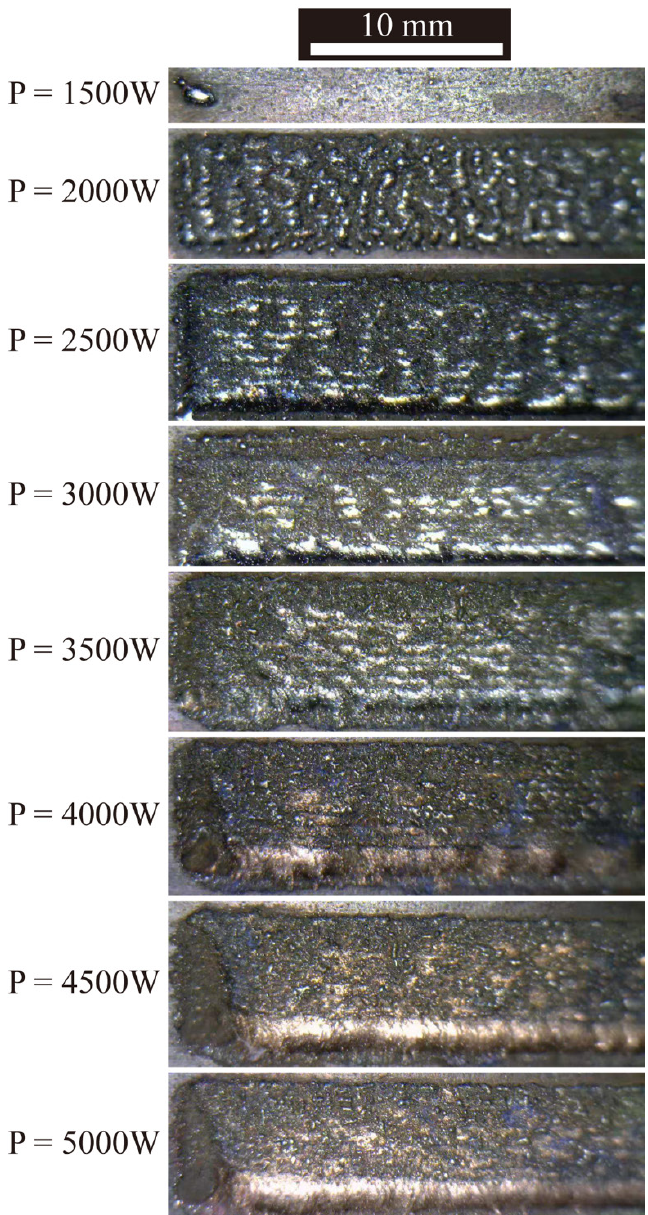
Figure 12. Surface morphologies of the single-layer specimens.